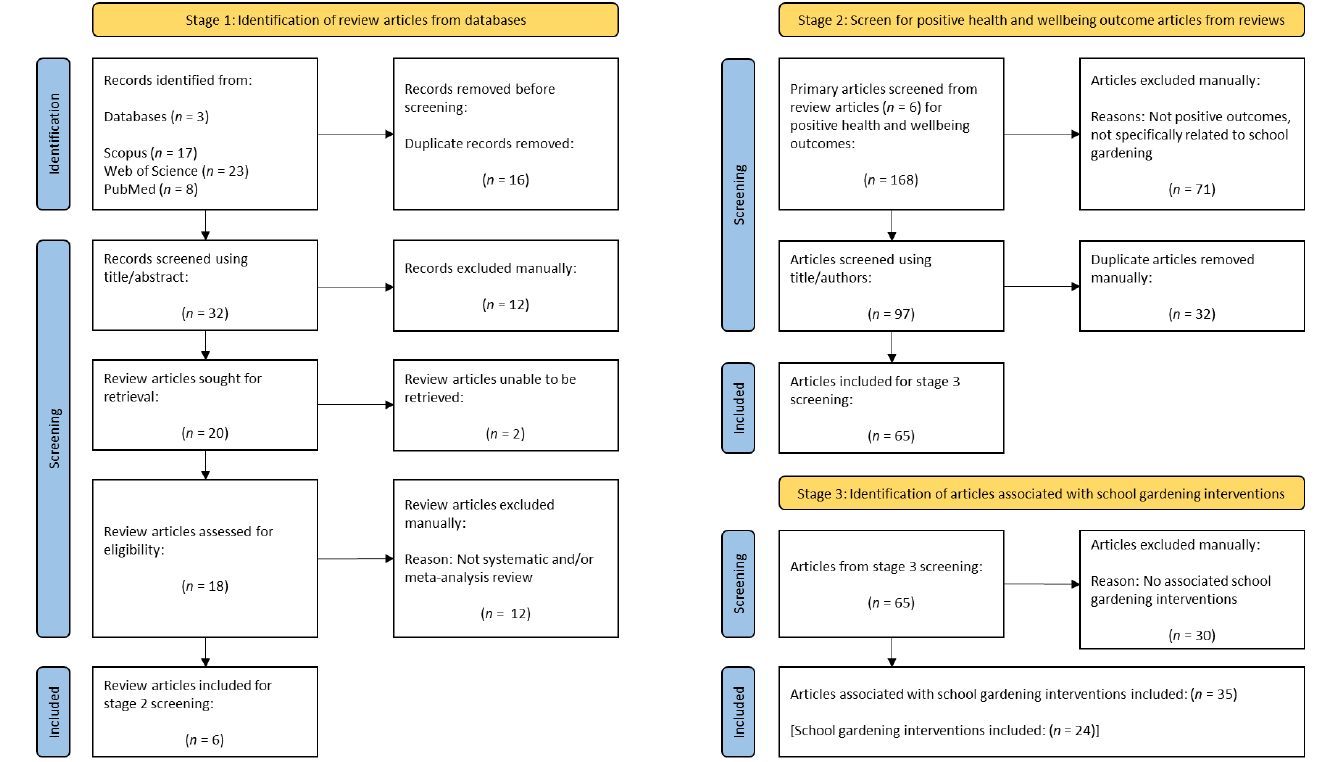
Figure 1. Three stages include identification of review articles, positive health and well-being articles, and articles associated with school gardening interventions.